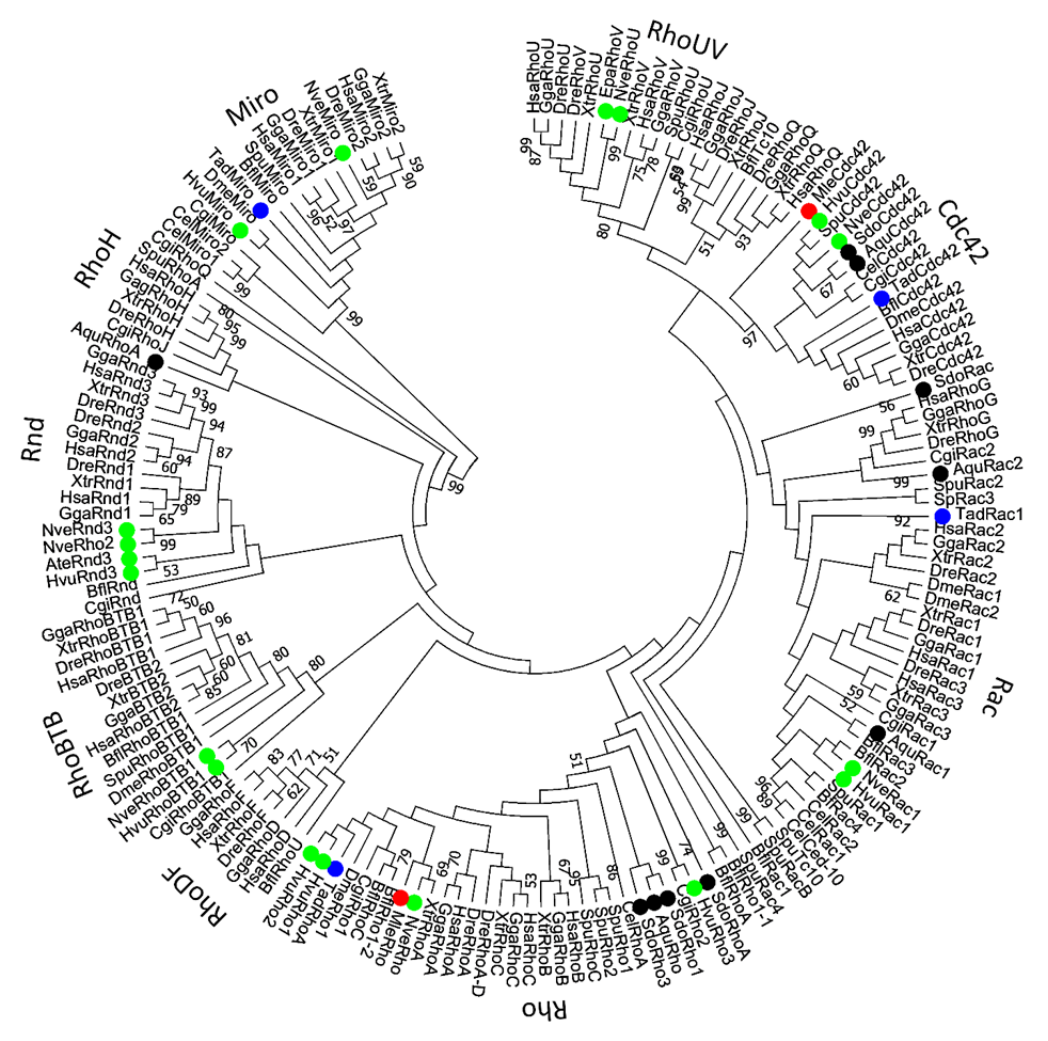
Figure 2. Phylogenetic tree of Rho GTPases in Metazoa. The evolutionary history of Rho GTPases from selected metazoan species (accession numbers are presented in Table S1.) was inferred using the Maximum Likelihood (ML) method based on the JTT matrix-based model [28]. Evolutionary analyses were conducted in MEGA7 [29]. The topological stability of the maximum likelihood (ML) tree was evaluated by 1000 bootstrapping replications. The bootstrapping values higher than 50 are indicated by numbers at the nodes. Rho GTPases from Cnidaria are marked in green, Porifera in black, Placozoa in blue, and Ctenophora in red.